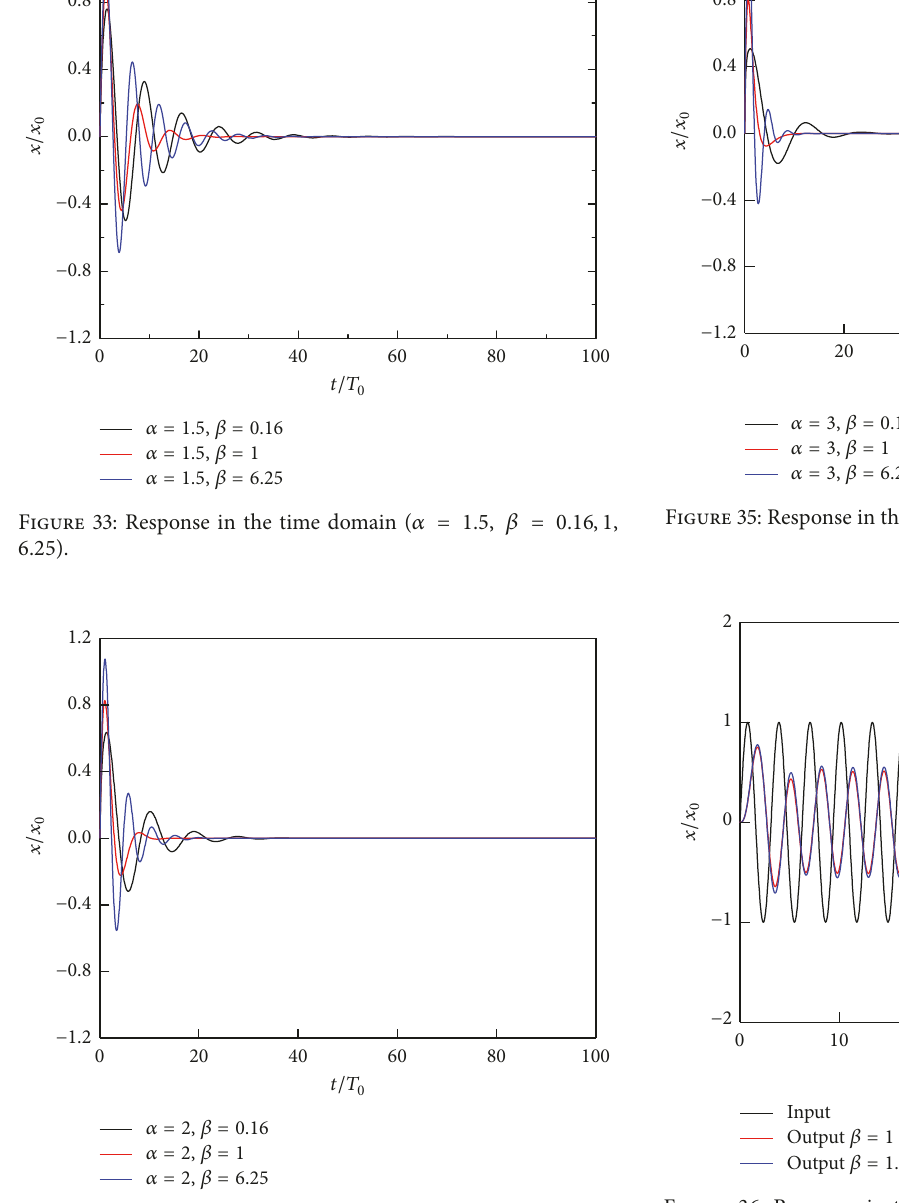
Figure 36: Response in the time domain ( 𝛼 = 2, 𝛽 = 1, 1.25, 𝜔/𝜔 = 2 0